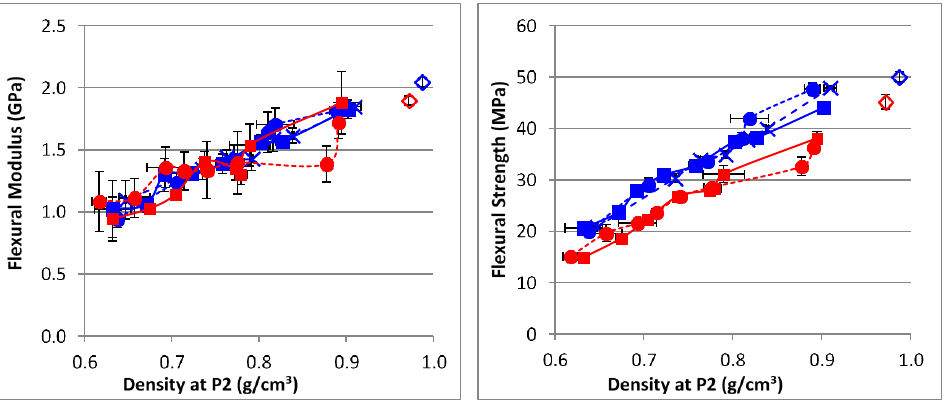
Figure 6. Dependence of the flexural modulus ( left ) and flexural strength ( right ) on the density of the foamed parts. Legend: PPCell, PPWood. Compact samples— ; samples N03_T60— , dashed line; samples N06_T60— , solid lines; samples N06_T40— , dotted lines. Error bars show 95% confidence interval. If not visible, error bars lie within the size of the used symbol for the respective sample. Impact Properties Figure 7 shows the unnotched (left) and notched (right) Charpy impact strength of PPWood and PPCell as a function of the density. The observed trends for the impact be- haviour differed from the tensile and flexural properties in several aspects: While the dis- crepancy between the two materials was almost negligible for the tensile and flexural modulus and in the range of 25–30% in favour of PPCell in the tensile and flexural strength, the differences in the impact properties were much more significant—roughly 250–300% in the unnotched impact strength and around 100% in the notched impact strength, both in favour of PPCell. There was again a roughly linear correlation between